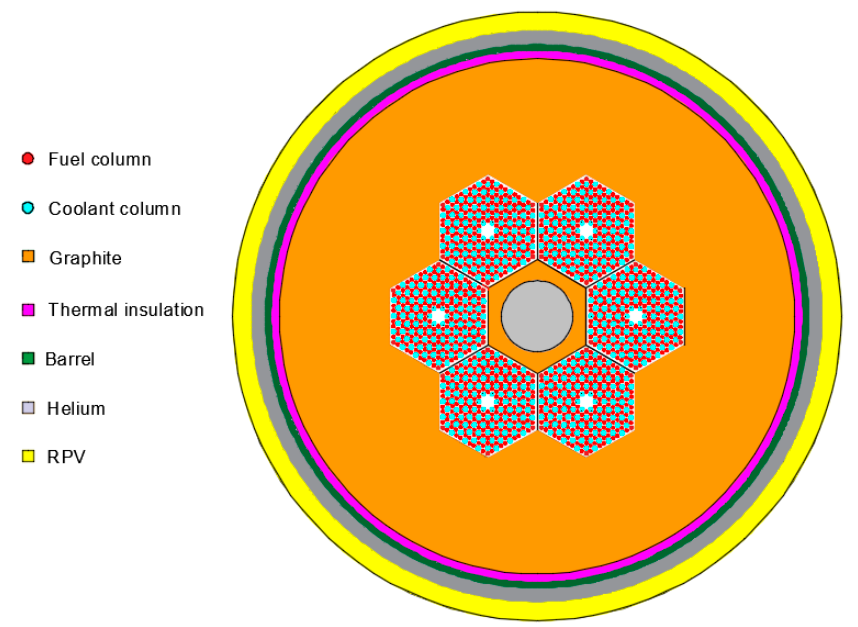
Figure 3. Central reflector removed in the centre of the core and replaced with helium coolant.